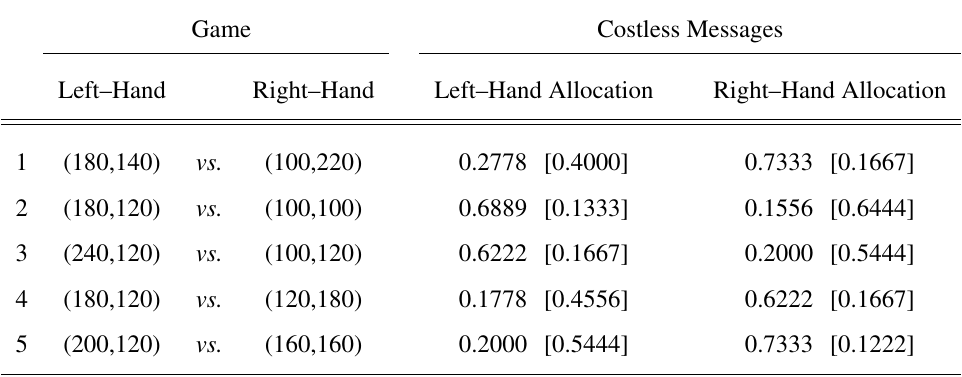
Table 1. Approval [Disapproval] rates of the recipients in the five dictator games using costless